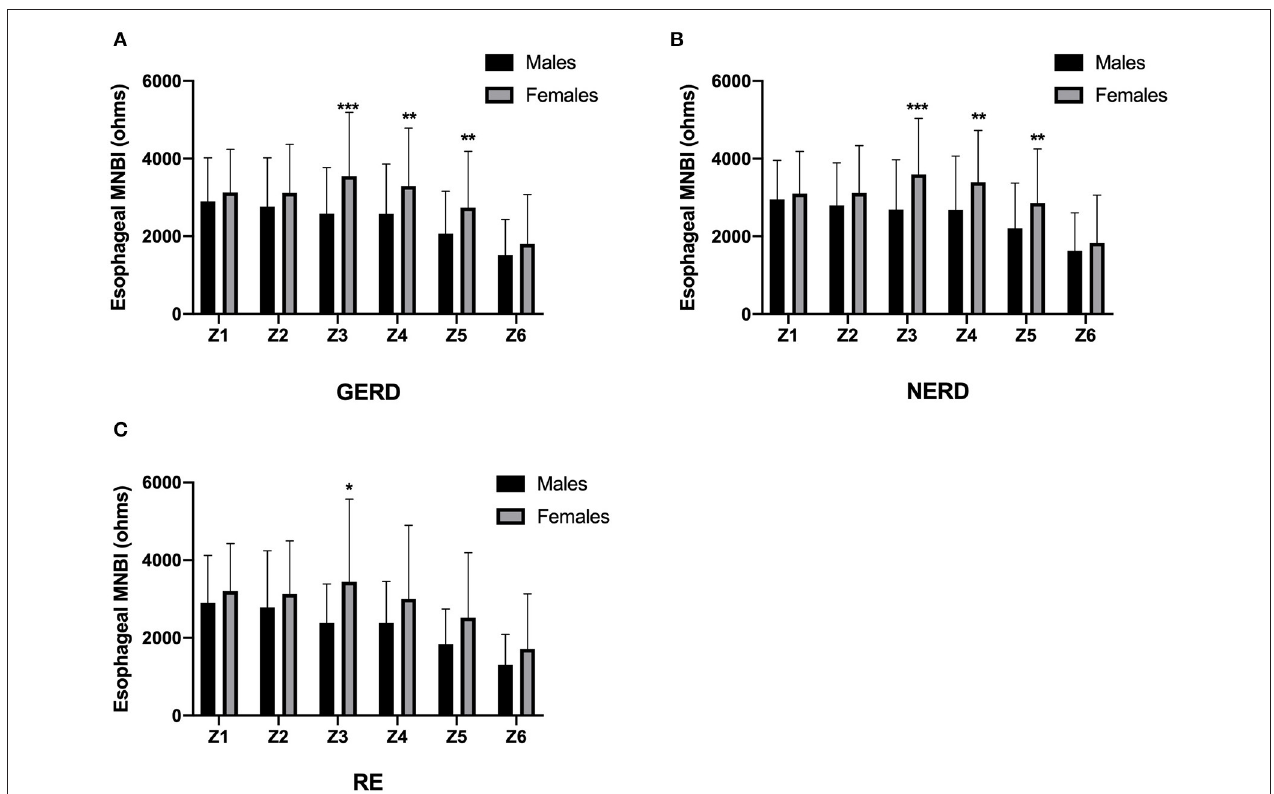
FIGURE 1 | MNBI values from each channel in females and males. MNBI from Z3 to Z5 were lower in males than in females in GERD patients (A) and NERD patients (B) , MNBI at Z3 were lower in males than in females in RE patients (C) . GERD, gastroesophageal reflux disease; NERD, non-erosive reflux disease; RE, reflux esophagitis; MNBI, mean nocturnal baseline impedance. * P < 0.05, ** P < 0.01 and *** P < 0.001 for males and females in each